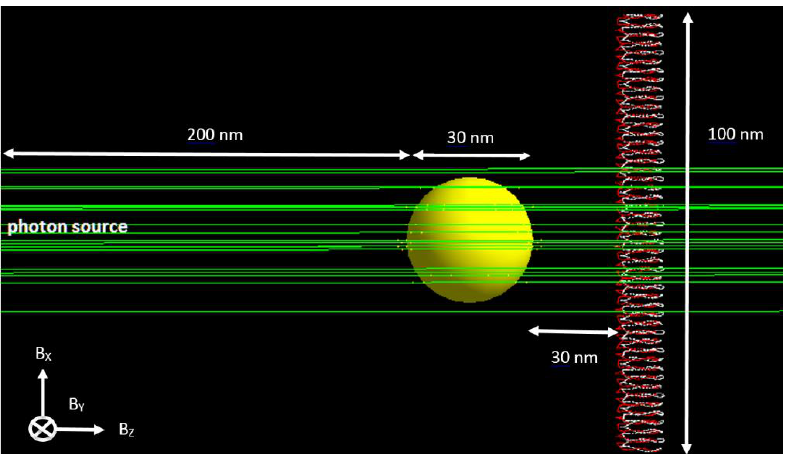
Figure 1. The Monte Carlo model geometry simulated in Geant4-DNA (not to scale). The gold nanoparticle was placed between the photon beam (green) and the DNA molecule. Nanoparticle diameters of 30, 50 and 100 nm were used in the